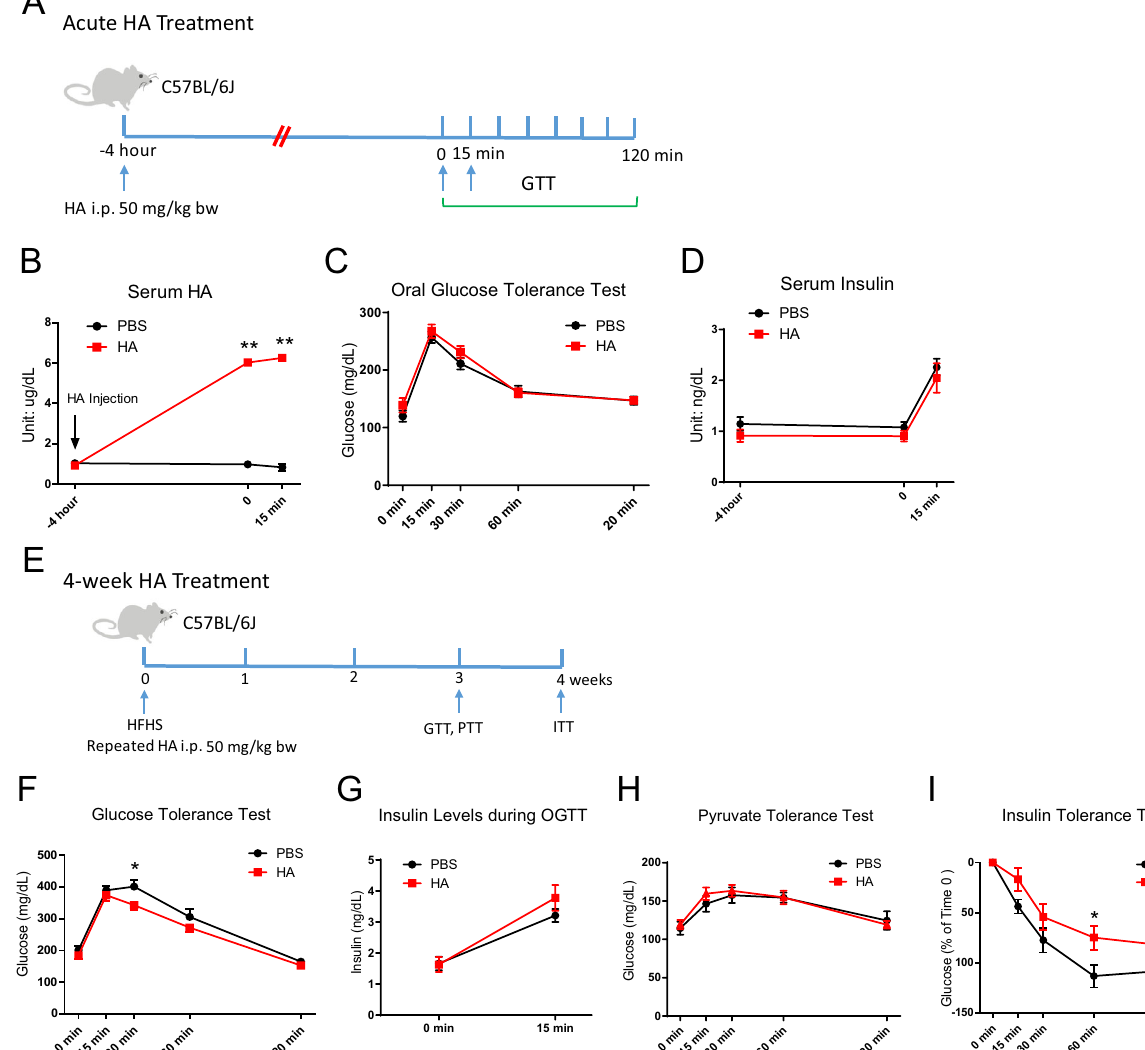
Fig. 5 Effects of HA i.p. injections on glucose metabolism. A Schematic representation of mouse treatment for panels B – D . B Serum HA levels after an HA i.p. injection ( n = 6 mice per group). Two-way ANOVA followed by Sidak ’ s multiple comparisons test, adjusted p -value = 0.8642, <0.0001, <0.0001 for -4 h, 0, and 15 min, respectively. C Oral glucose tolerance test 4 h after an HA i.p. injection ( n = 12 mice per group). D Serum insulin levels assayed at times indicated by blue arrows in panel A ( n = 12 mice per group). E Schematic representation of mouse treatment for panels F – I . Two cohorts of mice were used. F Repeated HA treatment effects on oral glucose tolerance ( n = 8 mice per group). Two-way ANOVA followed by Sidak ’ s multiple comparisons test, adjusted p -value = 0.9546, 0.9700, 0.0467, 0.4970, 0.9873 for 0, 15, 30, 60, and 120 min, respectively. G Serum insulin levels after an oral glucose challenge ( n = 4 mice for PBS, n = 6 mice for HA treatment). H Repeated HA treatment effects on pyruvate tolerance test ( n = 8 mice for PBS, n = 9 mice for HA treatment). I Repeated HA treatment effects on insulin sensitivity. Glucose levels are plotted as the percentage of Time 0 ( n = 8 mice). Two-way ANOVA followed by Sidak ’ s multiple comparisons test, adjusted p -value = 1, 0.2196, 0.3748, 0.0375, 0.6450 for 0, 15, 30, 60, and 120 min, respectively. All data are presented as mean ± s.e.m. *indicates p ≤ 0.05, **indicates p ≤ 0.01. Two-way ANOVA ( C ) ( D ) ( G ) ( H